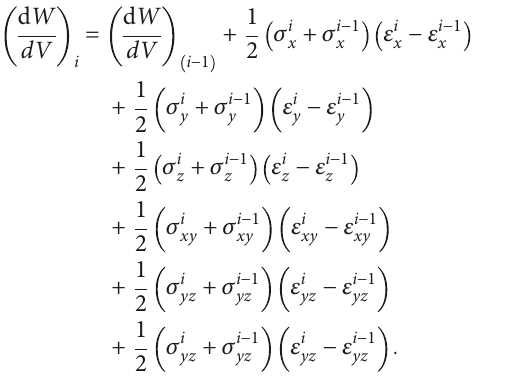
Figure 4. The boundary conditions of the model mechanics